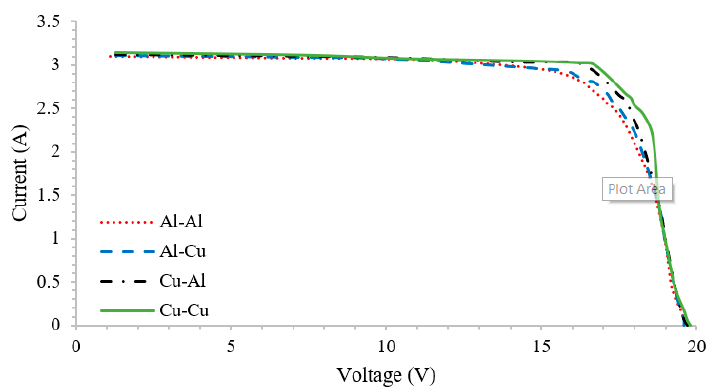
Figure 11. The effect of changing the power ( Isc vs. Voc ) on any change in material.